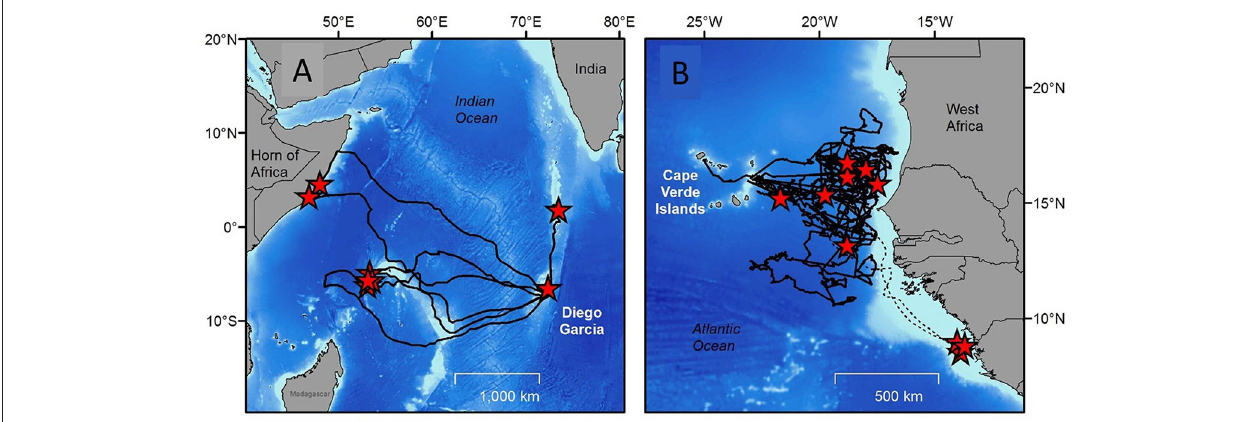
FIGURE 3 | “ How many tags are enough? ” is an important question for any tracking study. The answer to this question depends on the nature of the question being addressed and also the variability in behavior across individuals (A). Tracks of eight green turtles equipped with satellite tags on nesting beaches on the Indian Ocean Island of Diego Garcia. Some migrate only a few 10s of km to the Great Chagos Bank, while others travel around 2,000km to the Seychelles, and others still traveled almost 4,000km to the coast of East Africa. The high variability in destinations means that more turtles will need to be tracked from this nesting area to identify the full extent of foraging ground destinations across the Indian Ocean (redrawn with permission from Hays et al., 2014b) (B). The tracks of 10 loggerhead turtles tracked from nesting beaches on the Cape Verde Islands (Atlantic Ocean). Seven out of ten individuals (solid lines) foraged across more than 500,000 km 2 of oceanic areas without showing any focal behavior, while the remaining three (dashed lines) traveled to discrete foraging sites on the mainland coast of Africa. Here the rarer occurrence of travel to discrete foraging sites on mainland Africa might have been missed with a smaller sample size. Redrawn with permission from Hawkes et al.